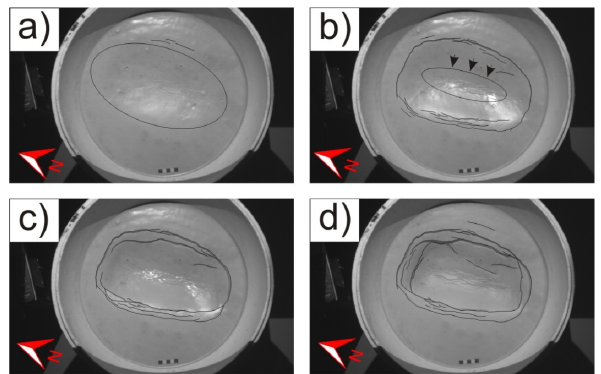
Figure 6. Photographic sequence of the second experiment show- ing the stages of deformation observed during desiccation of the model crater: (a) formation of a depression, (b) formation of frac- tures at the border of the depression and the displacement of ma- terial toward the depocenter, (c) growing and coalescence of faults, (d) desiccation of the model and formation of shortening structures in the